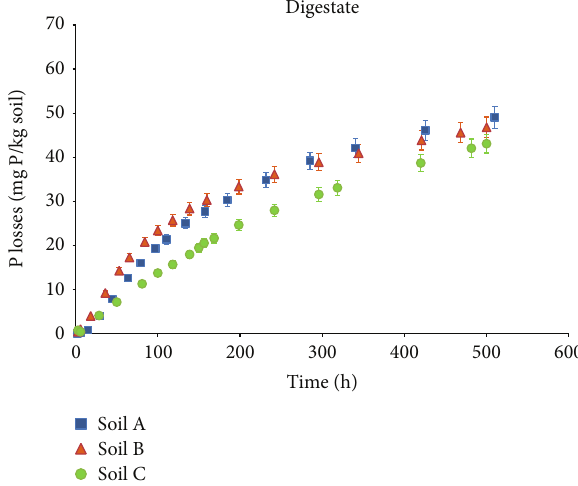
Figure 4: DRP losses by leaching in soil-digestate mixtures. Error bars indicate the standard error of the mean ( 𝑛 = 3 ).